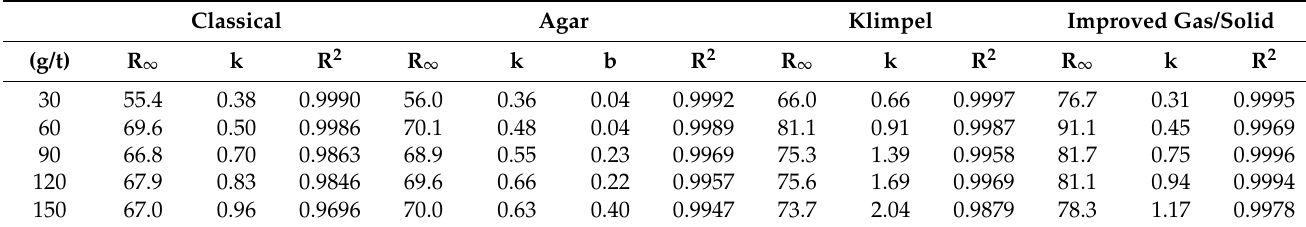
8 of 11 Figure 6. Foam changes for different flotation times: MIBC dosage, 120 g/t; kerosene dosage, 500 g/t; agitation speed, 1200 rpm.